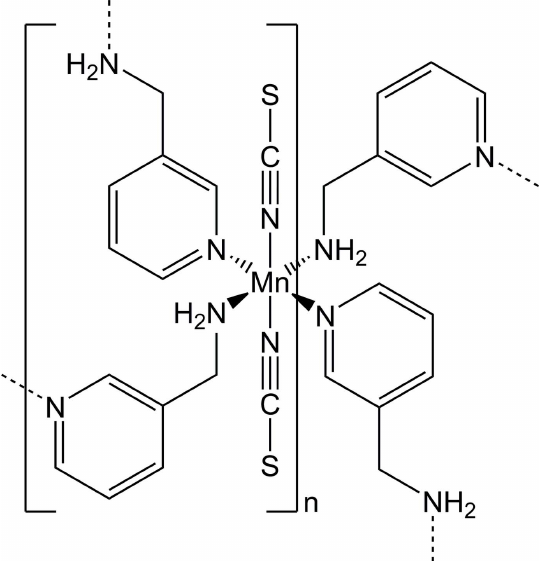
(cid:3) x , (cid:3) 1 (cid:3) z , (C) (cid:3) 1 (cid:3) y , + y , 1 + x , 3 2 2 2 2 2